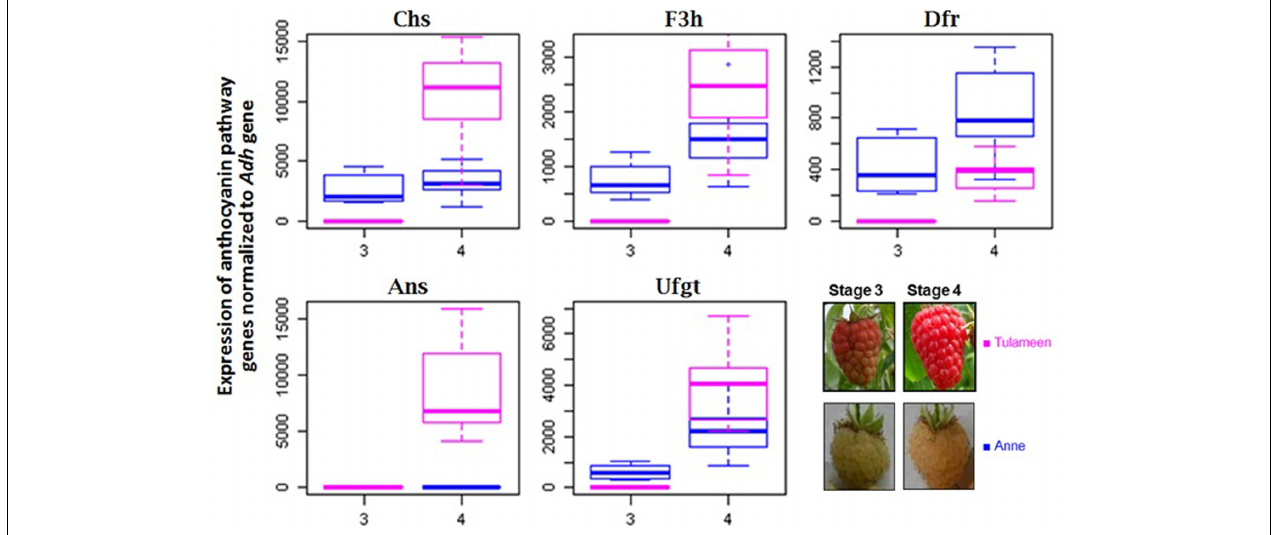
FIGURE 1 | Expression analysis of biosynthetic flavonoid pathway genes in cv. “Tulameen” and “Anne”. Expression of Chs. chalcone synthase; F3h. flavanone 3 β -hydroxylase; Dfr, dihydroflavonol 4-reductase; Ans, anthocyanidin synthase; Ufgt UDPG-flavonoid-glycosyltransferase at fruiting stage 3 and 4 in yellow variety “Anne” and red variety “Tulameen”, respectively. The inset picture shows an example of a red and a yellow raspberry at the respective fruit ripening stages. Box plots show the mean values of the expression level with standard deviation, while dots give the sample